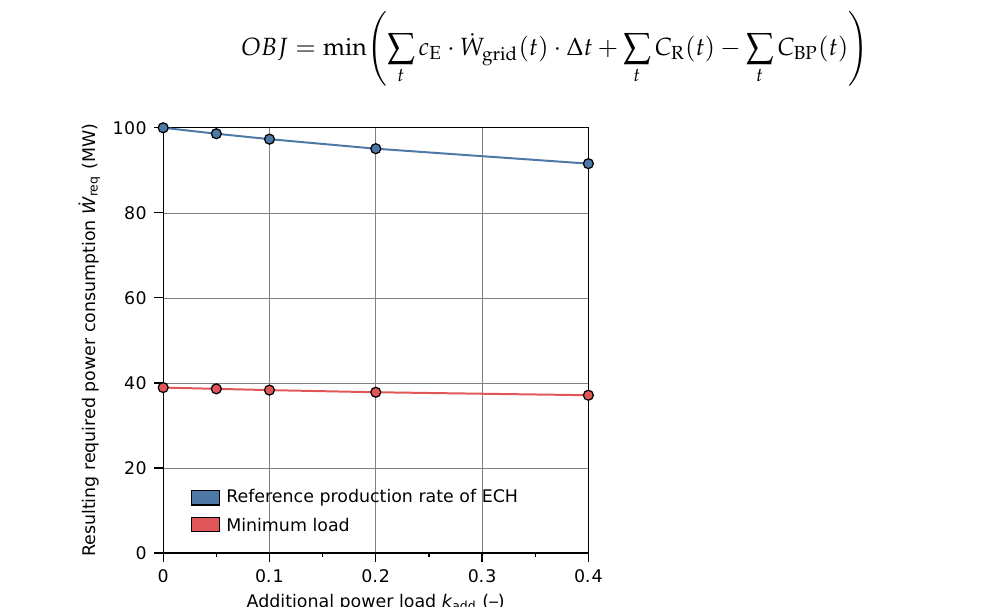
Figure 4. Minimum load and power consumption at reference production rate of ECH according to additionally installed